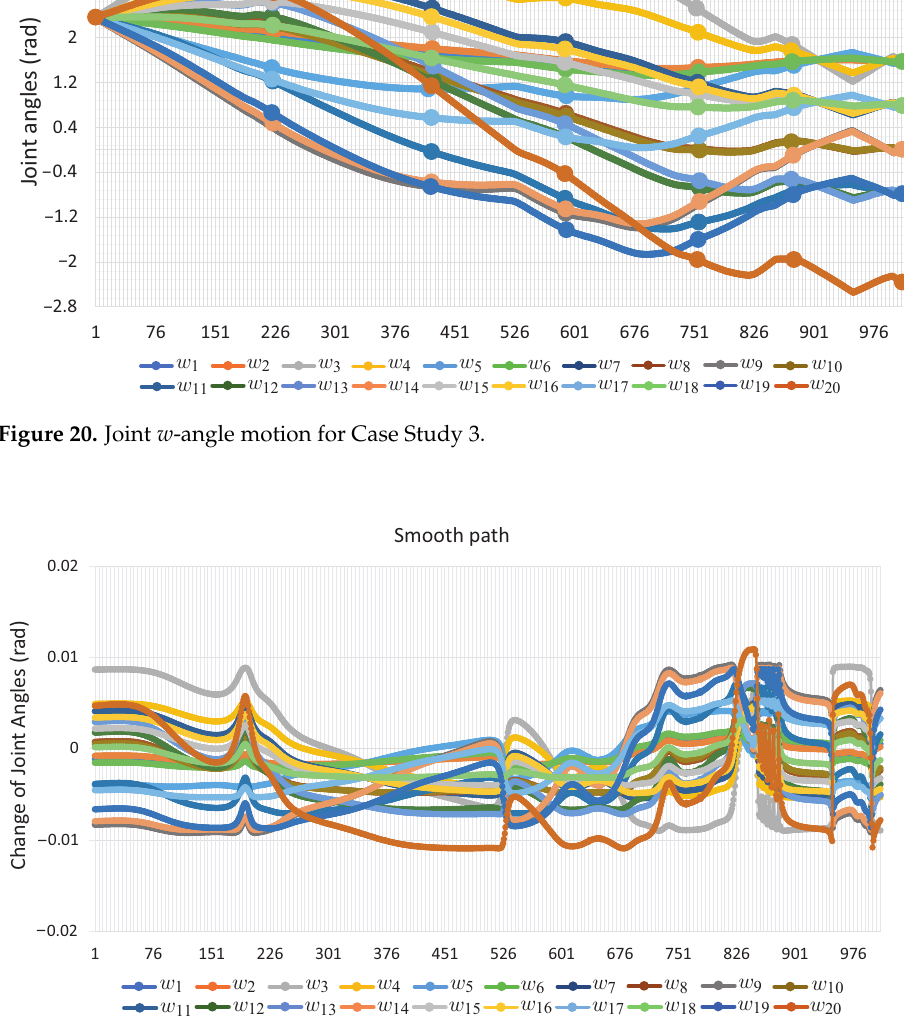
Figure 21. Change of joint angle motion of Case Study